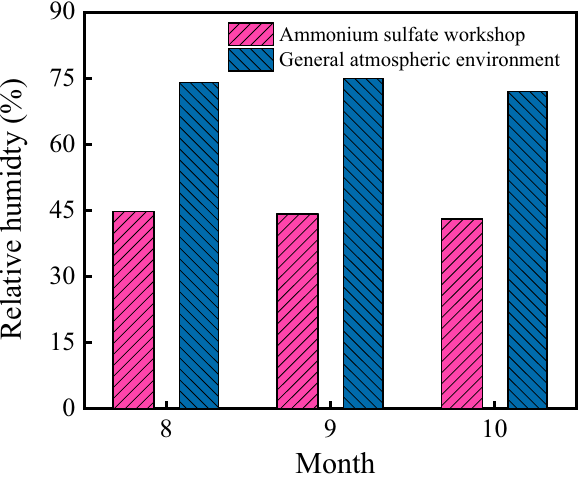
Figure 3. Relative humidity in the ammonium sulfate workshop and general atmospheric environment.